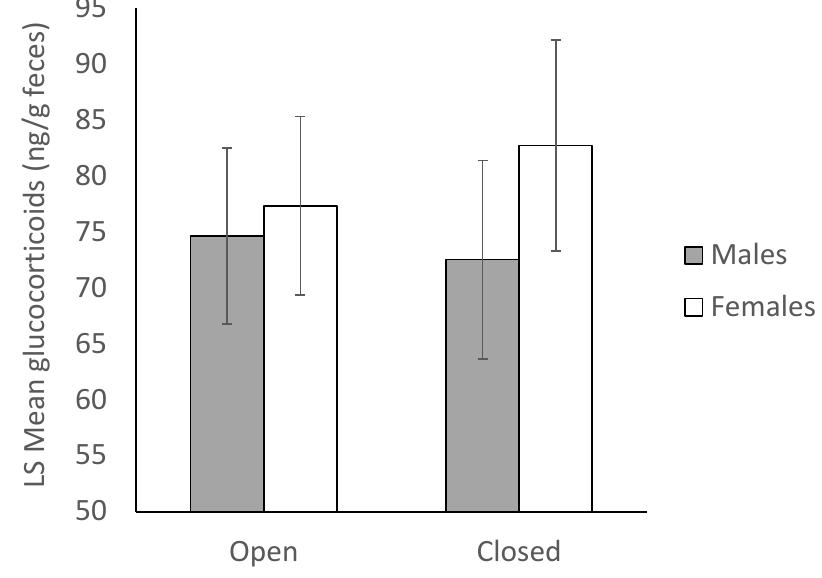
Figure 6. Least Squares Mean ± SEM fecal glucocorticoid concentrations during and outside of a temporary closure of the Children’s Zoo during the study (N gpigs = 16, N samples = 160). There was no significant effect of the closure on hormone levels in the on-exhibit females or the off-exhibit males.